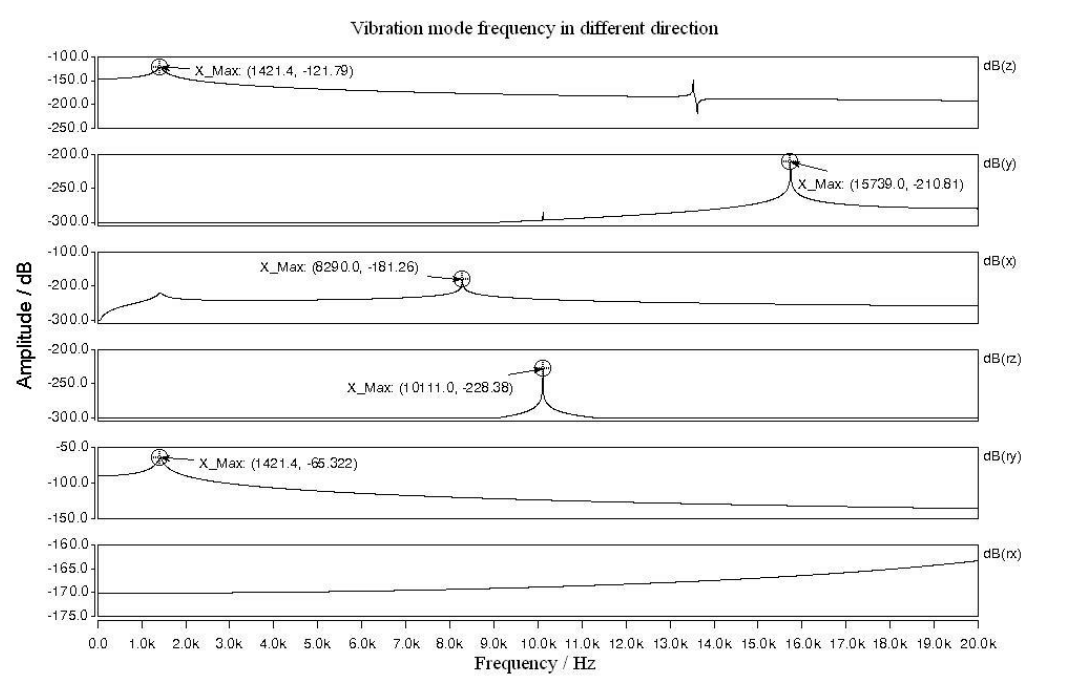
Figure 8. Different vibration modes of the silicon resonator of the